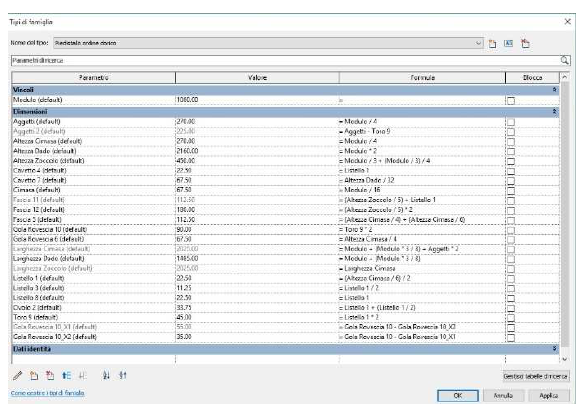
Figure 3. Creation of an instance parameter: Family type, parameter name, value and formula